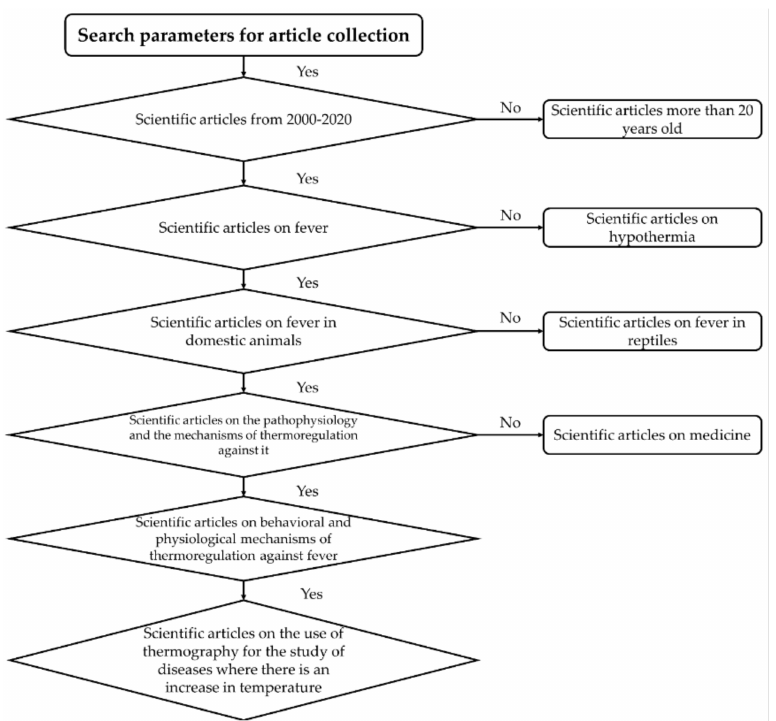
Figure 1. Flowchart showing the criteria used during the search of scientific articles for the